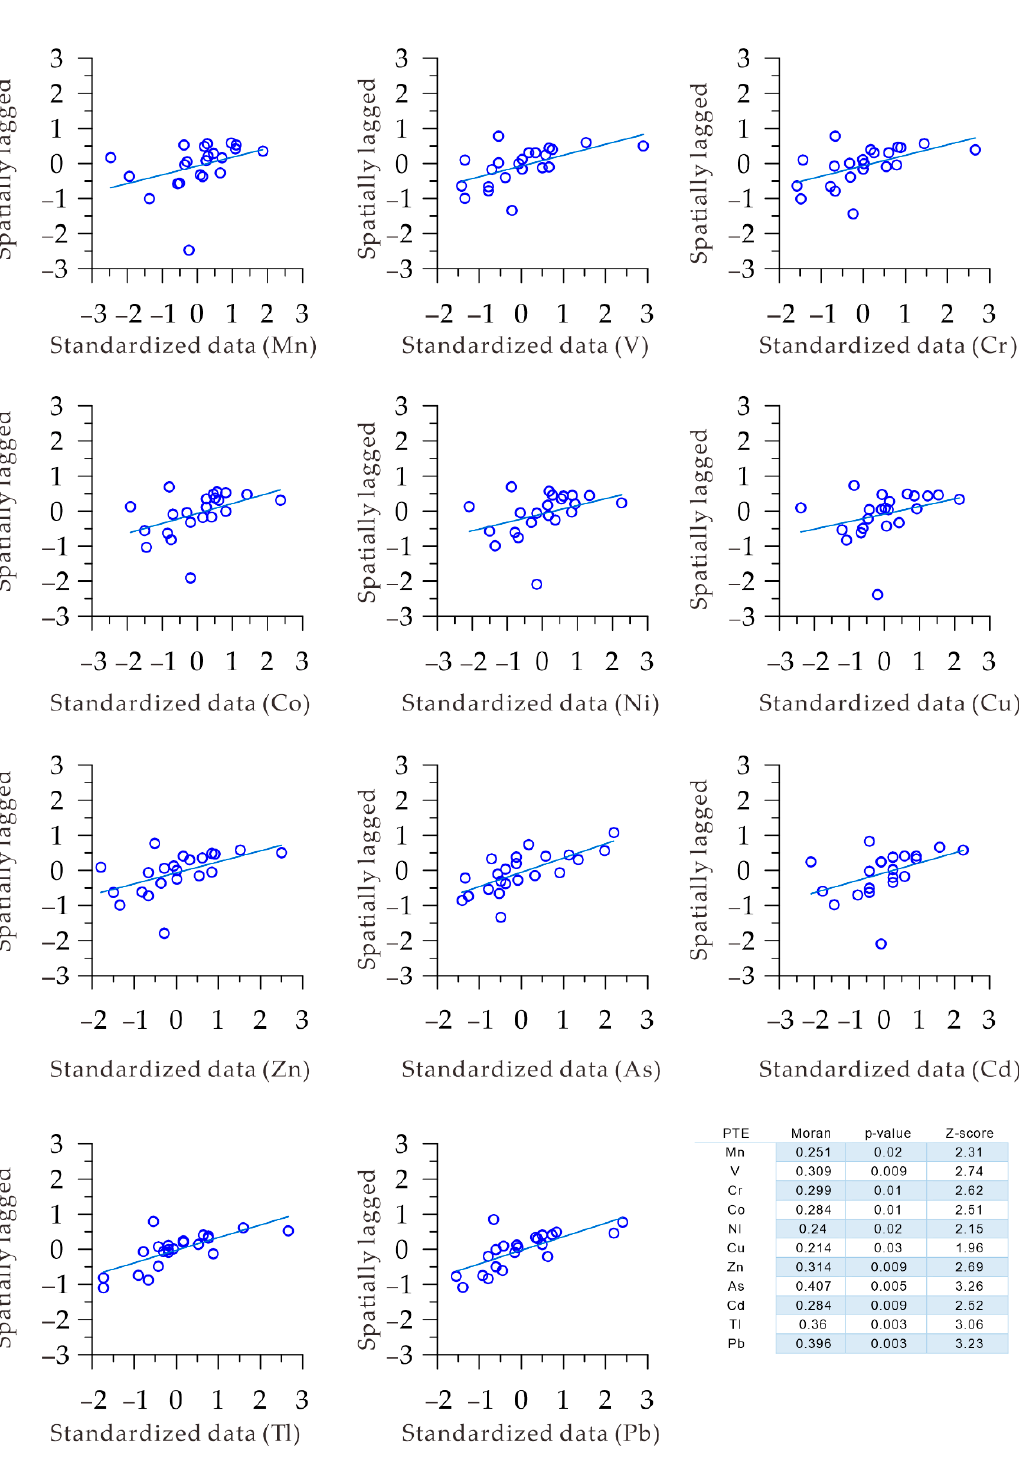
Figure 4. Moran’s I plots for the PTEs and statistic test results for Moran’s I.